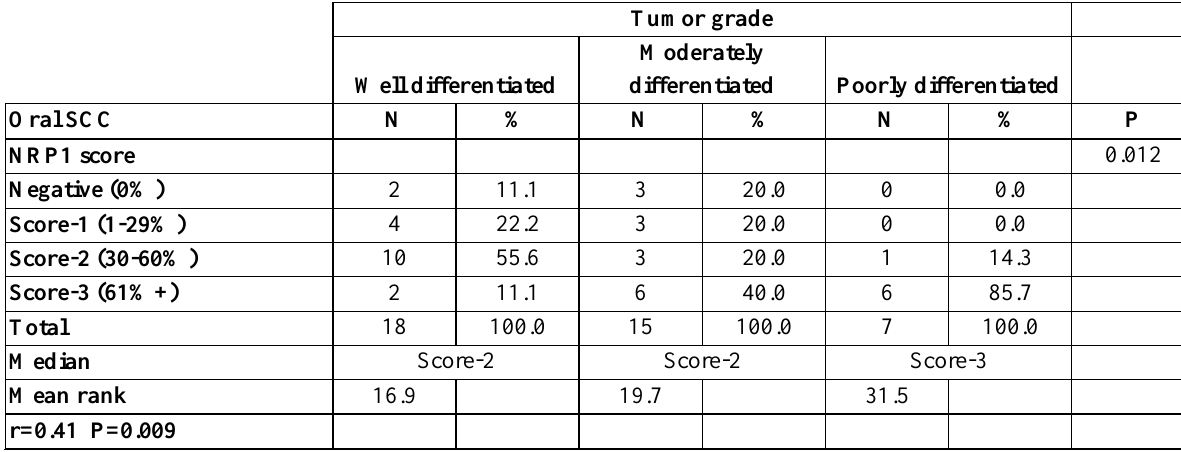
Table 4: The difference in median score category of selected NRP1 marker between the 3 tumor grades among cases with oral SCC.